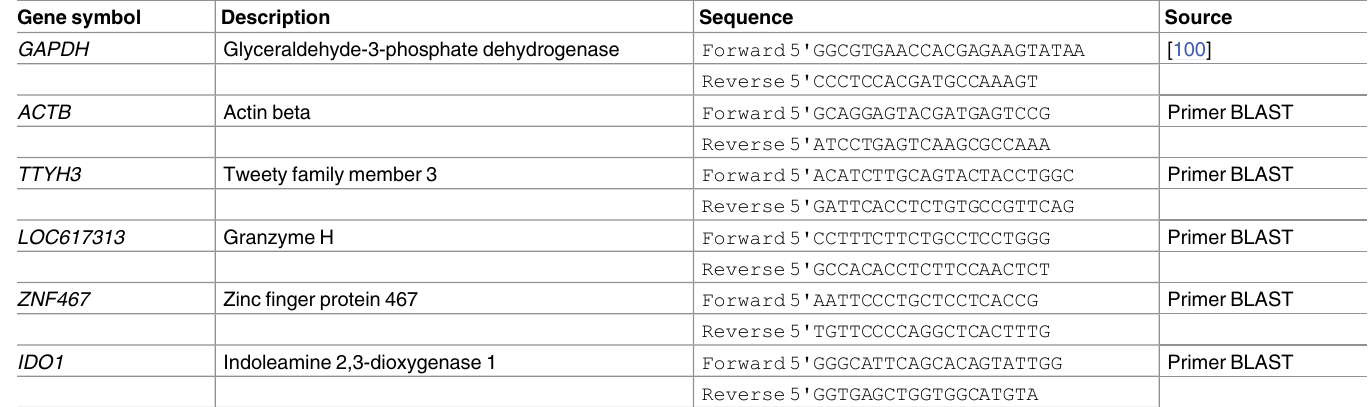
Table 7. Primers used for